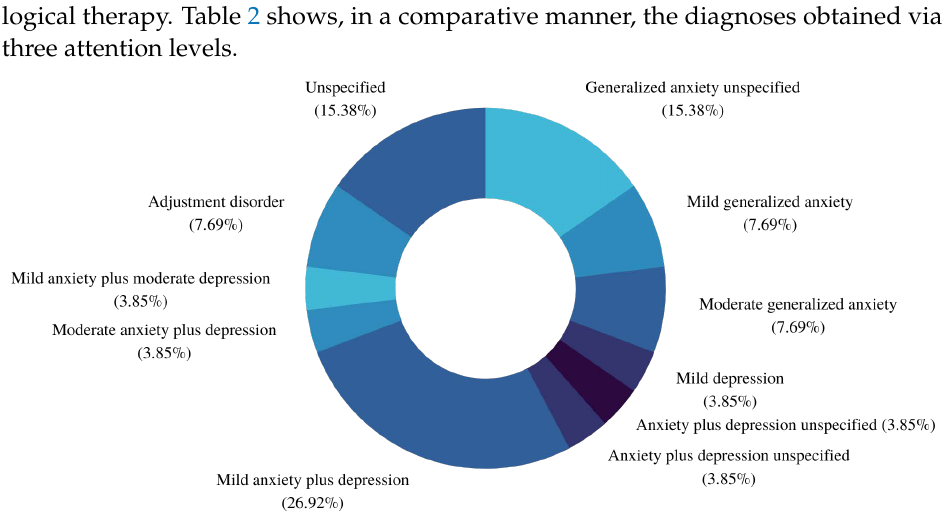
Figure 4. Frequency of psychological diagnoses obtained during the study. Each fraction of the plot represents a percentage calculated from the total number of patients who agreed to and received psy- chological care ( n = 26). There were four patients who were categorized as unspecified because they did not complete the intervention, and therefore their diagnostic impression could not be integrated. Table 2. Summary of diagnoses of mental health conditions obtained using Mentali, and psychological and psychiatric